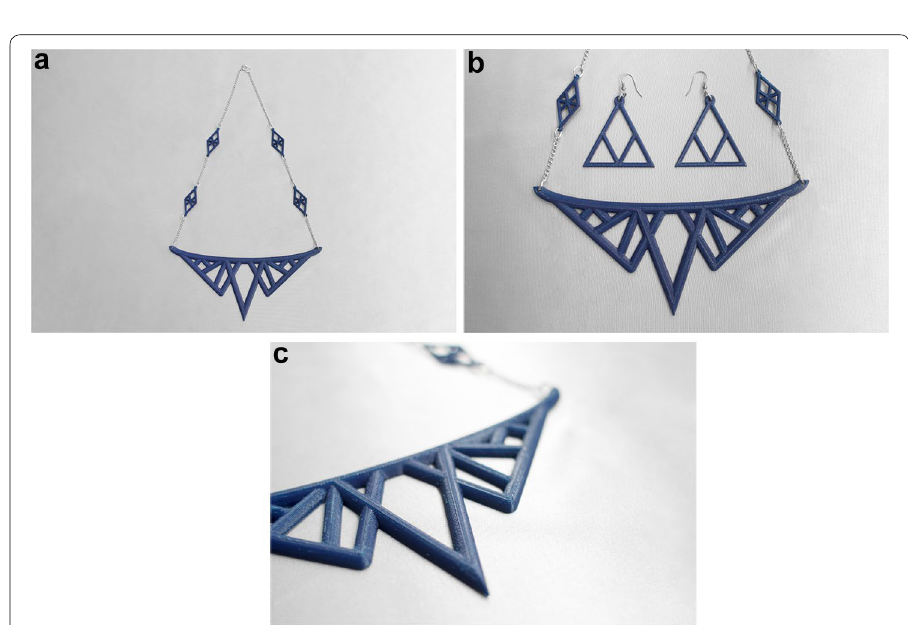
Zoomed view of jewelry pendant design